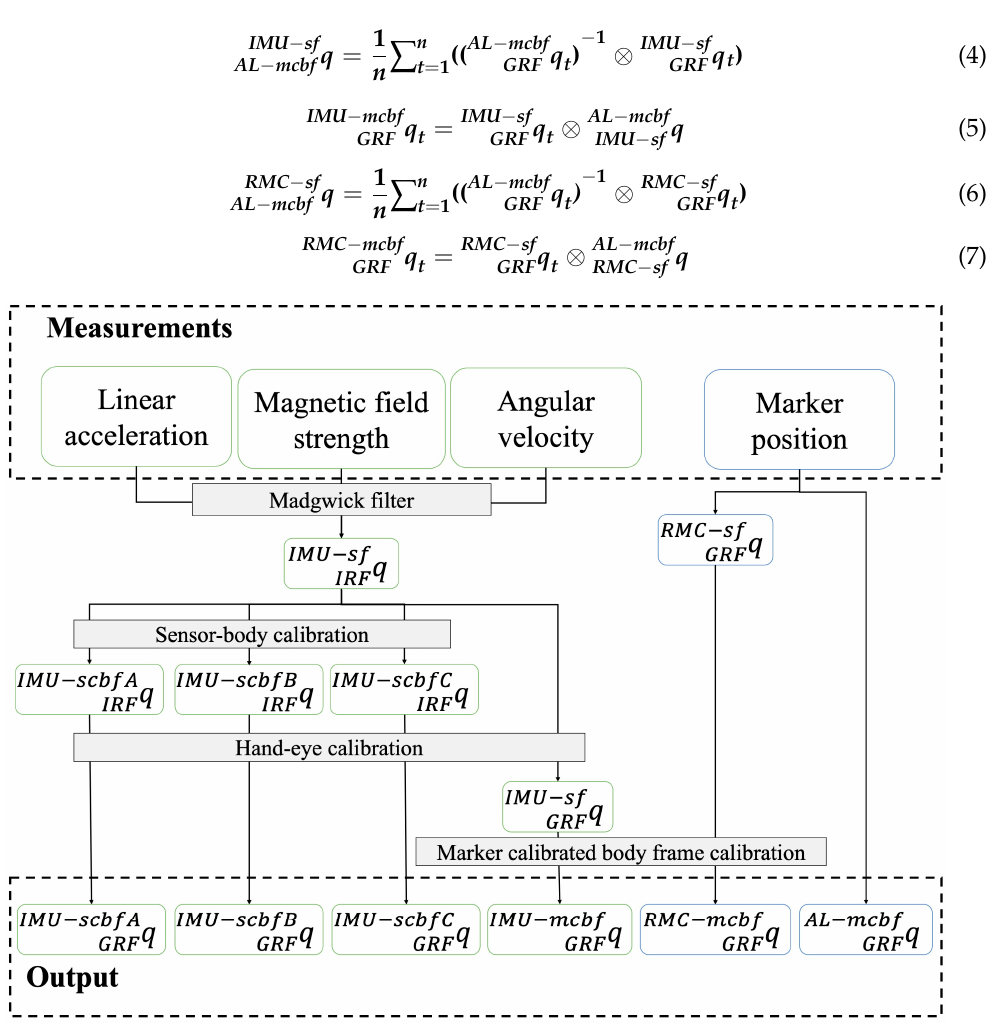
Figure 3. Data processing flow chart. Measurements were converted to rotation quaternions between two frames. IRF = IMU Reference Frame, GRF = Global Reference Frame, IMU-sf = IMU sensor frame, IMU-scbf(A–C) = IMU sensor calibrated body frame A, B and C, RMC-sf = RMC sensor frame, AL-mcbf = Anatomical Landmarks marker calibrated body frame, IMU-mcbf = IMU marker calibrated body frame, and RMC-mcbf = RMC marker calibrated body frame. The sensor-body calibration is based on the different calibration movements(A–C). The hand-eye calibration is based on the marker compass measurement. The marker calibrated body frame calibration is based on a static trial.